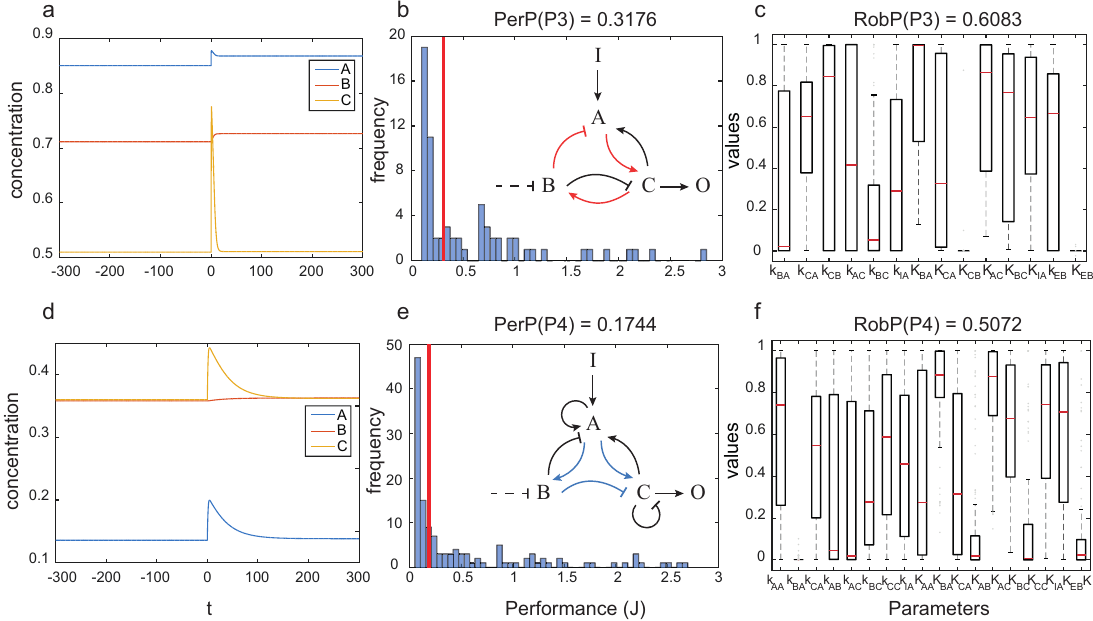
Figure 8. Pareto solutions with best compromise between robustness and global performance: ( a ) dynamics of one particular circuit with topology P 3; ( b ) performance and ( c ) robustness for topology P 3; ( d ) dynamics one particular circuit with topology P 4; and ( e ) performance and ( f ) robustness for topology P